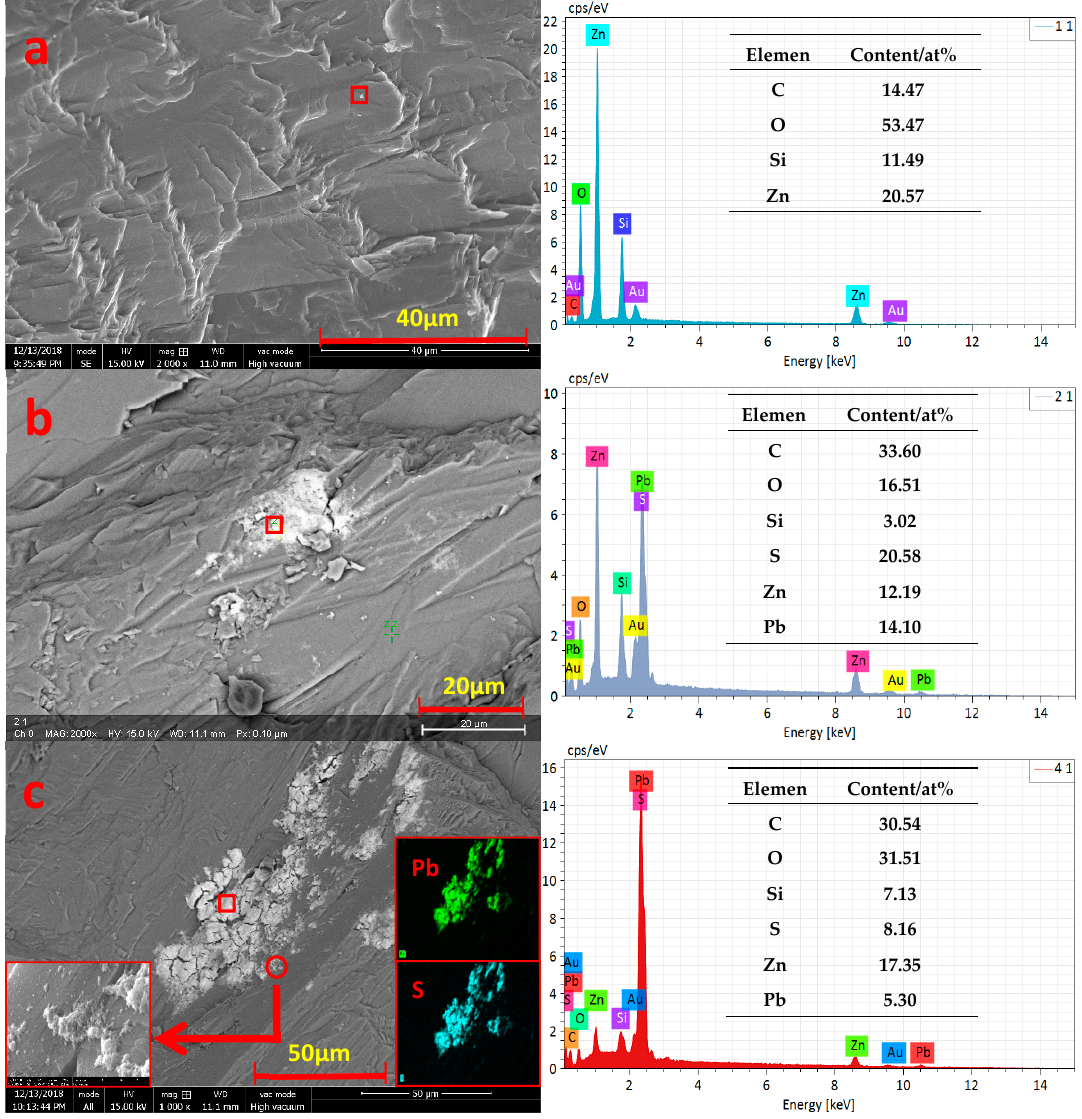
Figure 5. SEM– Energy-dispersive X-ray spectroscopy (EDS) results for the samples: ( a ) hemimorphite + Na 2 S·9H 2 O; ( b ) hemimorphite + Na 2 S·9H 2 O + Pb 2+ ; ( c ) hemimorphite + Pb 2+ + Na 2 S·9H 2 O + Pb 2+ .